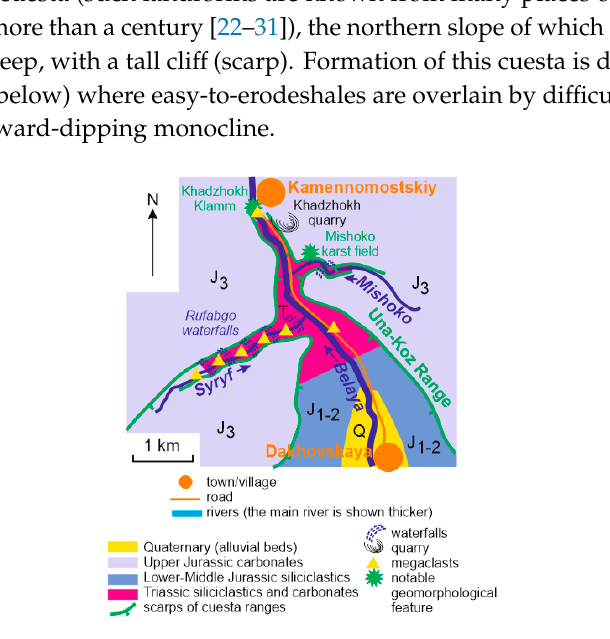
Figure 2. Geomorphological and geological elements of the study area.